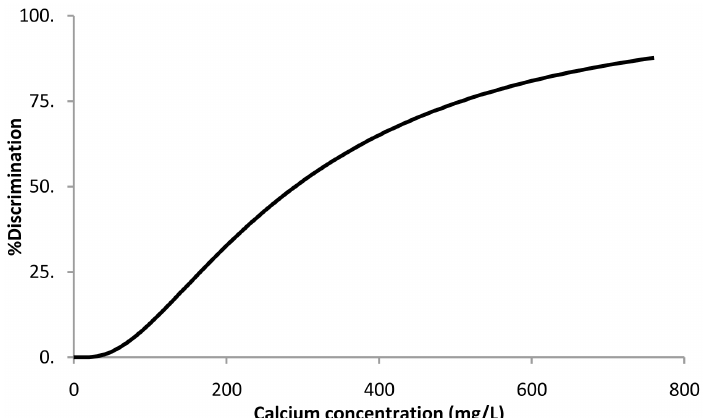
Figure 3. Calcium chloride dihydrate threshold taste. Percent discrimination versus calcium concentration for the log normal